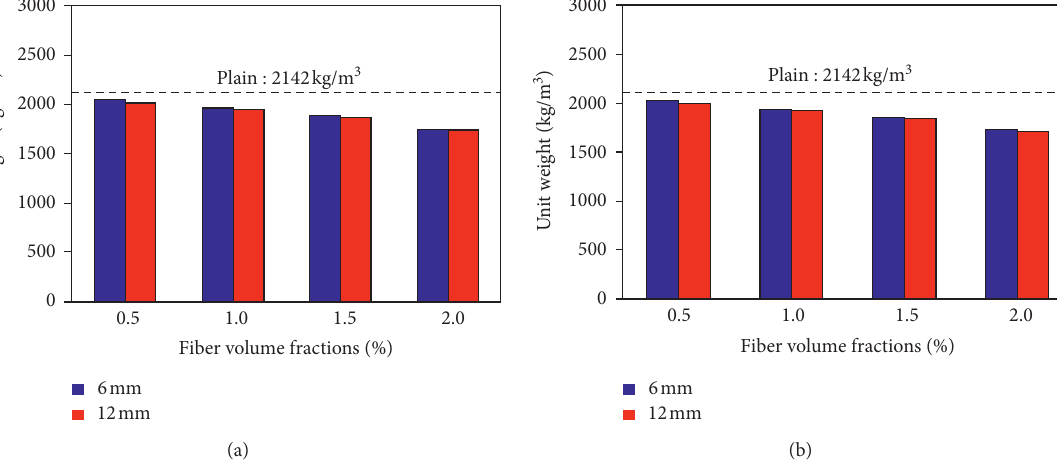
2 -coated carbon fiber and (b) uncoated